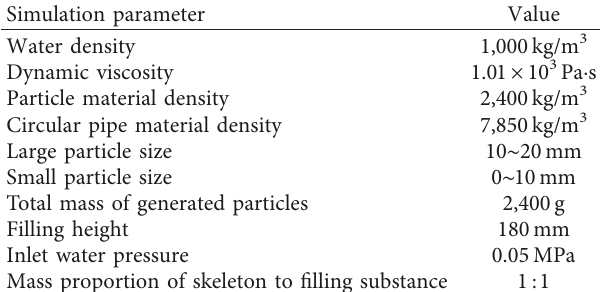
Table 1: Numerical simulation